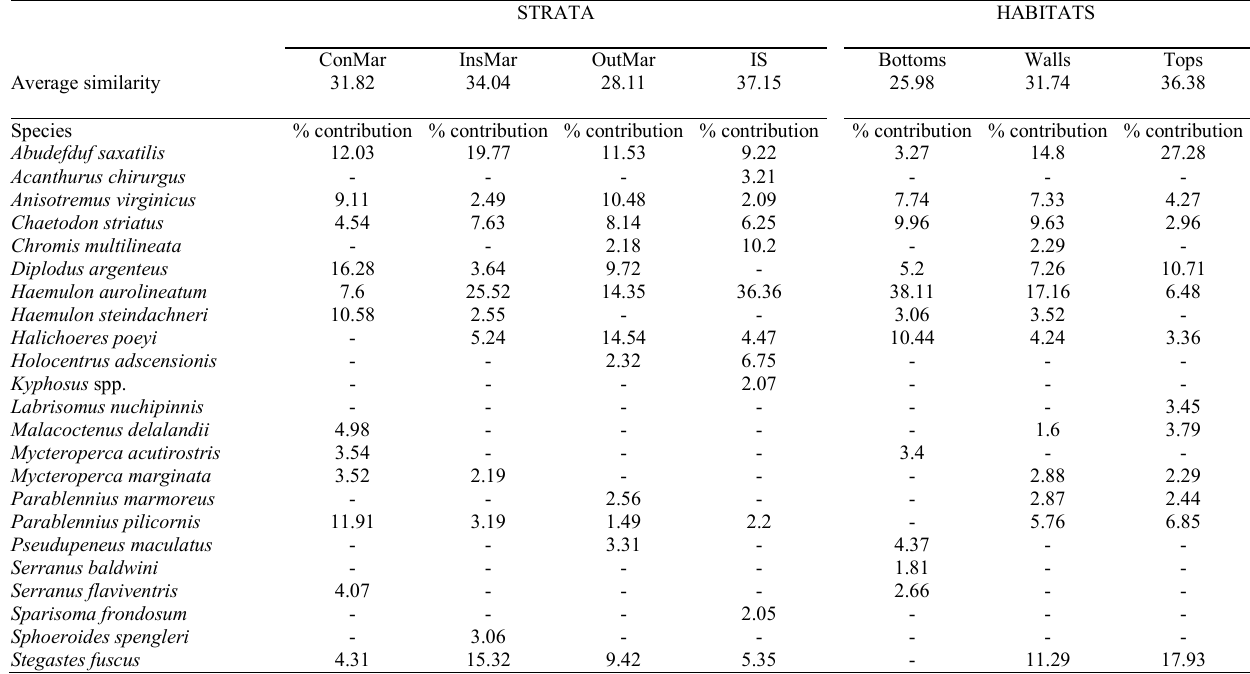
Table 3. Fish species with greater contribution to dissimilarity in each stratum and habitat (Percentage Similarity Analysis - SIMPER). ConMar = Continental Margin of the São Sebastião Channel; InsMar = Insular Margin of the São Sebastião Channel; OutMar = Outer Margin of São Sebastião Island; IS = islands (Alcatrazes, Búzios and Vitória). Only the 31 species representing more than 0.45% of total abundance were